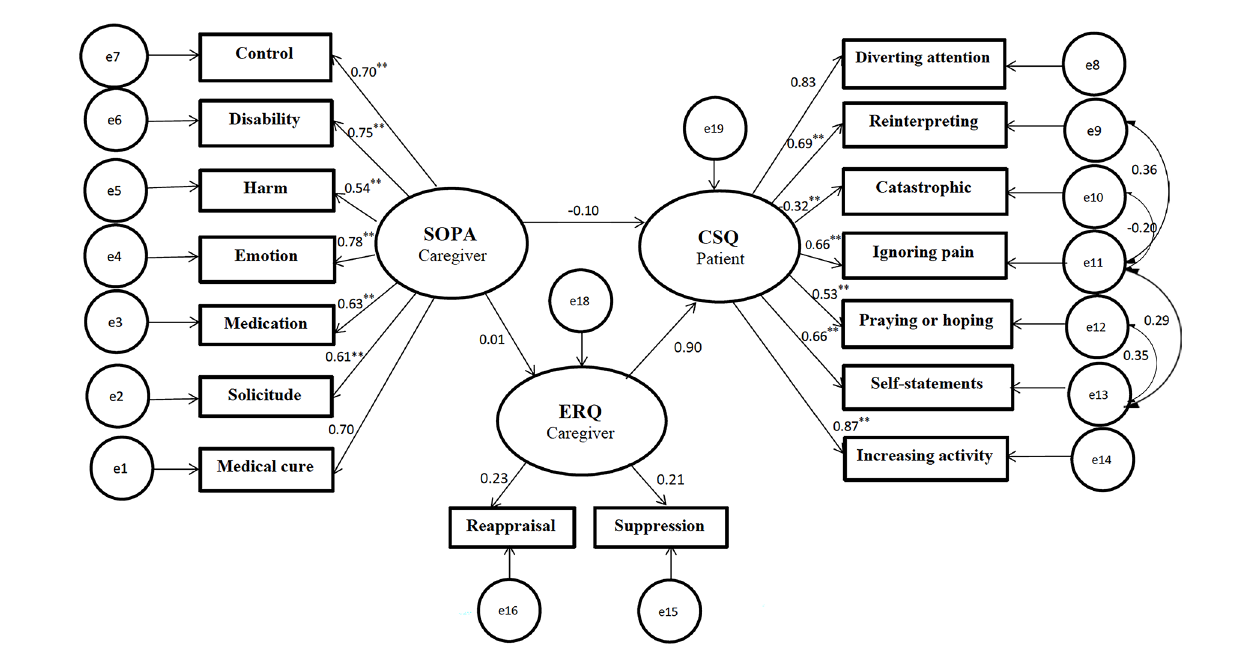
FIGURE3 Predicted relationship based on Model 2 (with resulting standardized regression weights). All coefficients are significant ( p < 0.001 ∗∗ ). SOPA, survey of pain attitudes; CSQ, coping strategies questionnaire; ERQ, emotion regulation